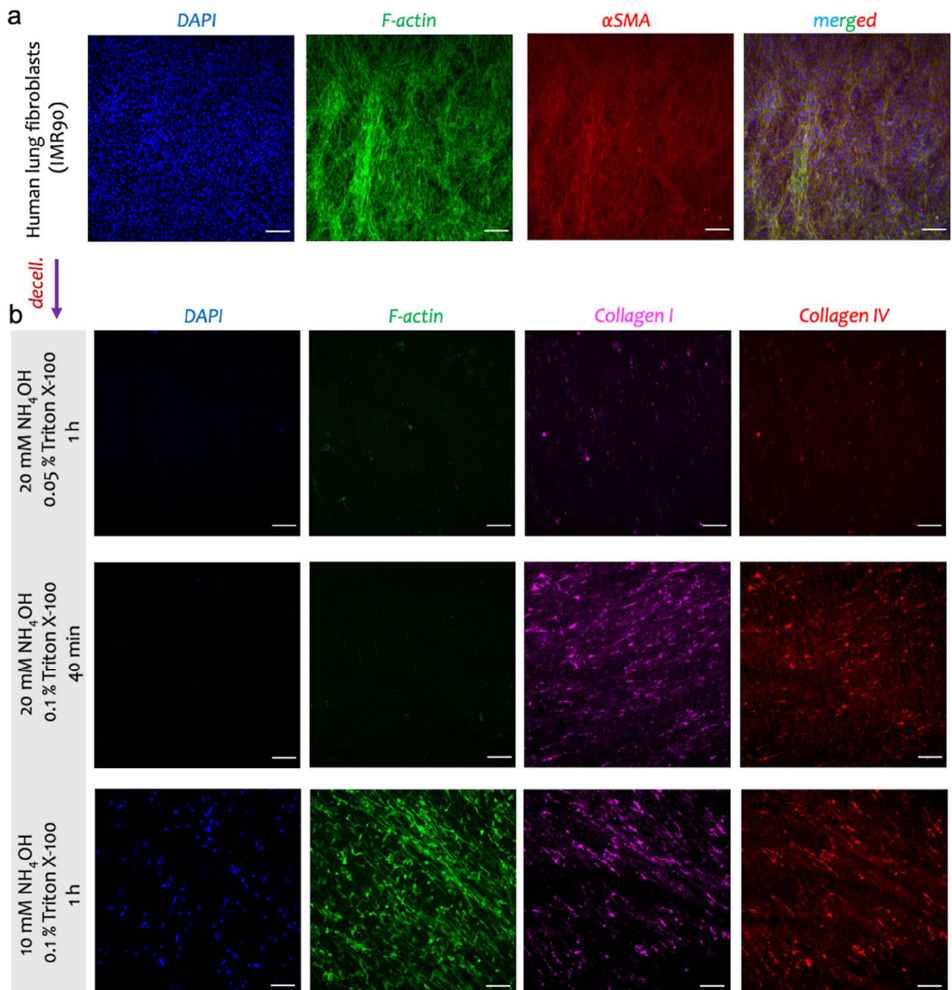
Figure 3. The IF analysis of the ECM-integrated BETA membrane. ( a ) the IMR90 human lung fibroblast cells were cultured on the BETA membrane and treated with 5 ng mL − 1 TGF β 1. The activated fibroblasts (myofibroblasts) characterized by α SMA (in red) produced high amounts of ECM proteins in response to a fibrotic agent of TGF β 1. ( b ) The populated scaffolds with IMR90 cells were subsequently decellularized. The selected acellular BETA membrane shows the complete or partial removal of cells retaining collagen I and IV as the two key ECM proteins. Protocol 2 ( 20 mM NH 4 OH and 0.1% Triton X-100 for 40 min) with DNAse I treatment (100 U/mL in PBS with Ca 2+ and Mg 2+ ) was preferred as the optimized decellularization protocol. Details of the decellularization protocols are shown in Table 1. Collagen I (magenta), collagen IV (red), F-actin cytoskeleton (green), and cell nuclei (DAPI, blue). Scale bars are 100 µ